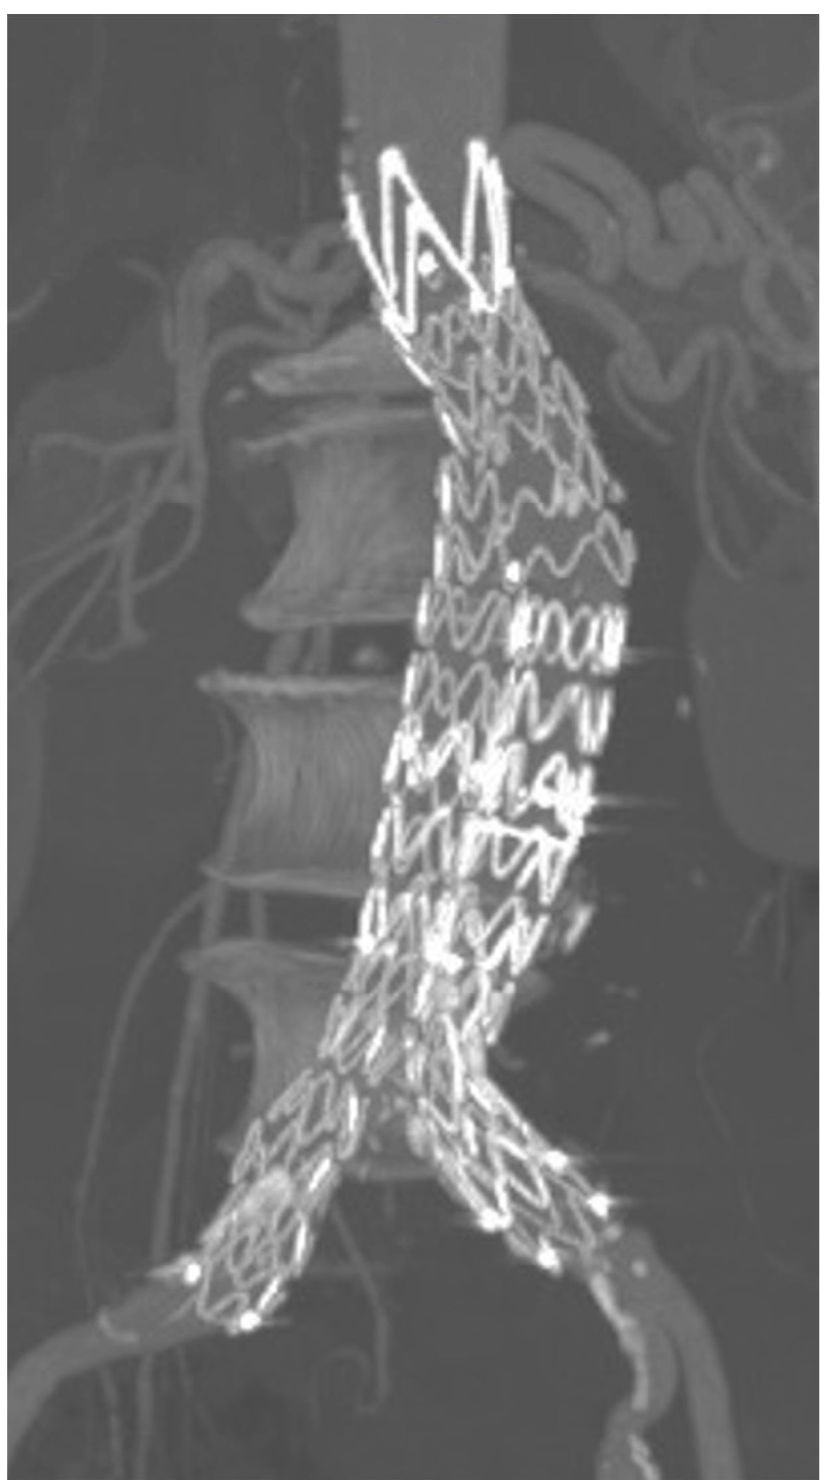
Figure 2. Multiplanar CTA reconstruction confirming good technical success and complete aneurysm exclusion during follow-up.